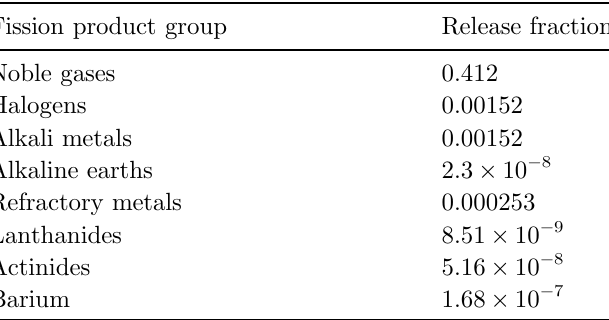
Table 1. Fission product groupings of the generic large